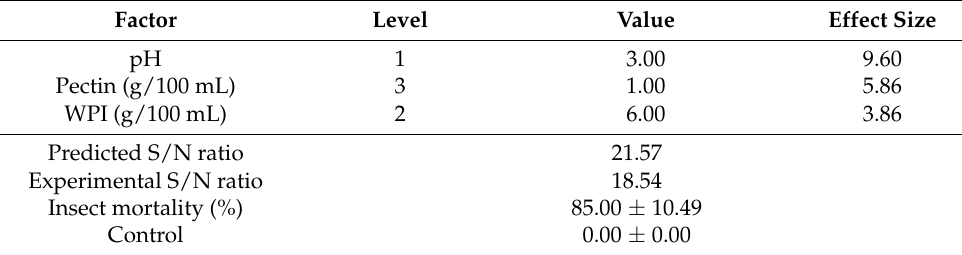
Table 3. Optimal conditions for the microencapsulation of neem extract.